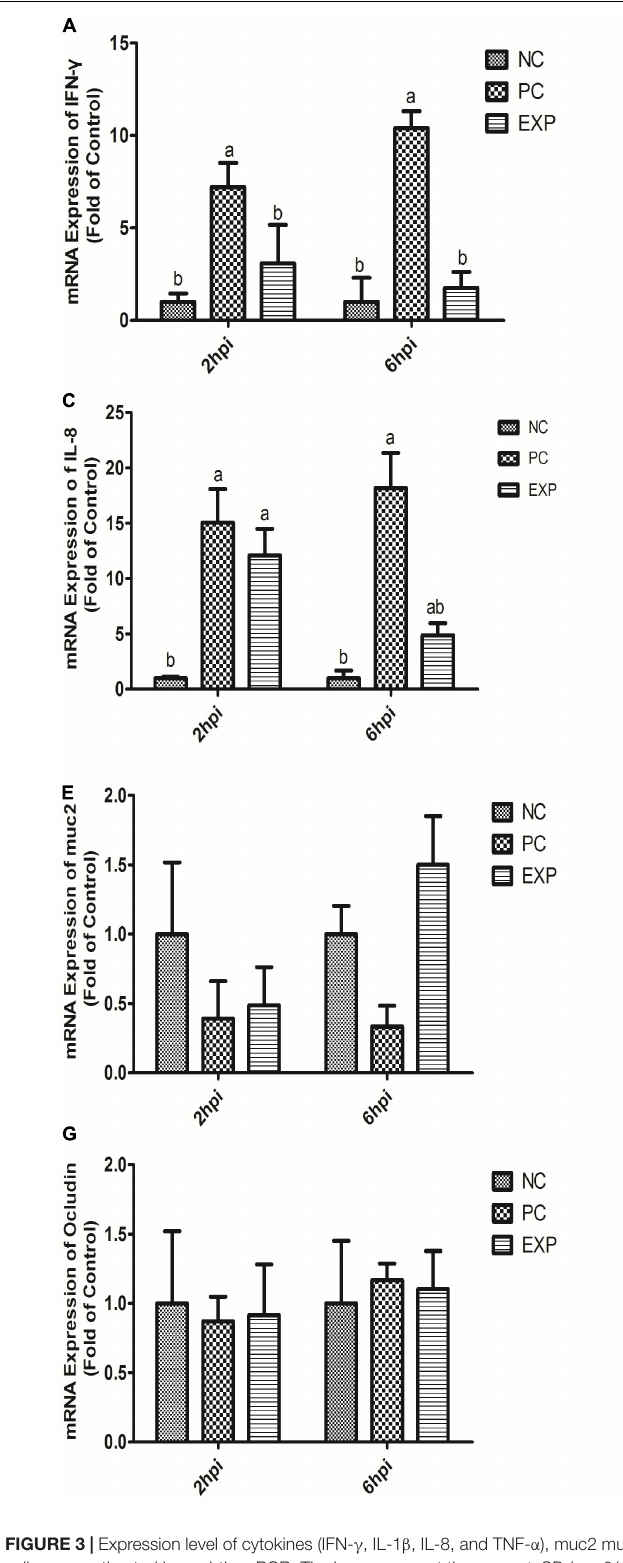
Frontiers in Microbiology |